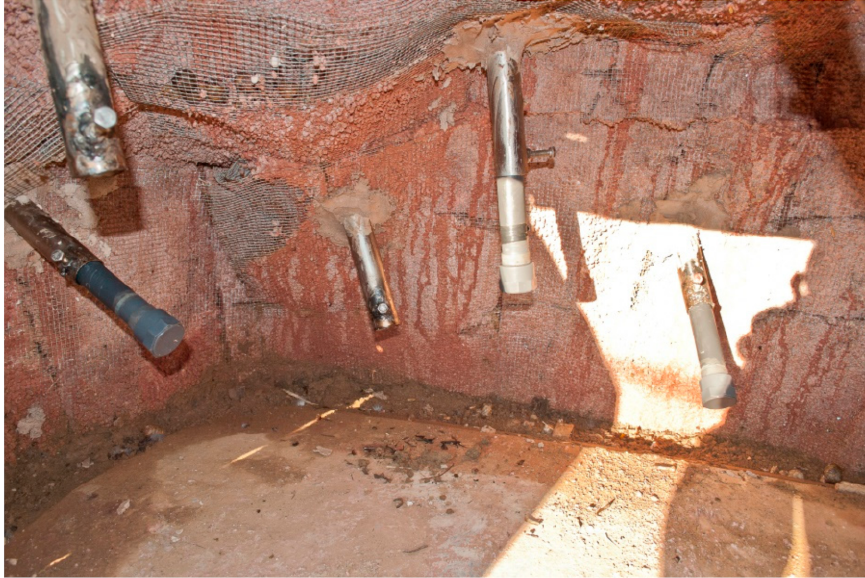
Figure 2. Details of the PVC tubes attached inside of the termite mound (Mutamba group). Credit: M. Llorente.